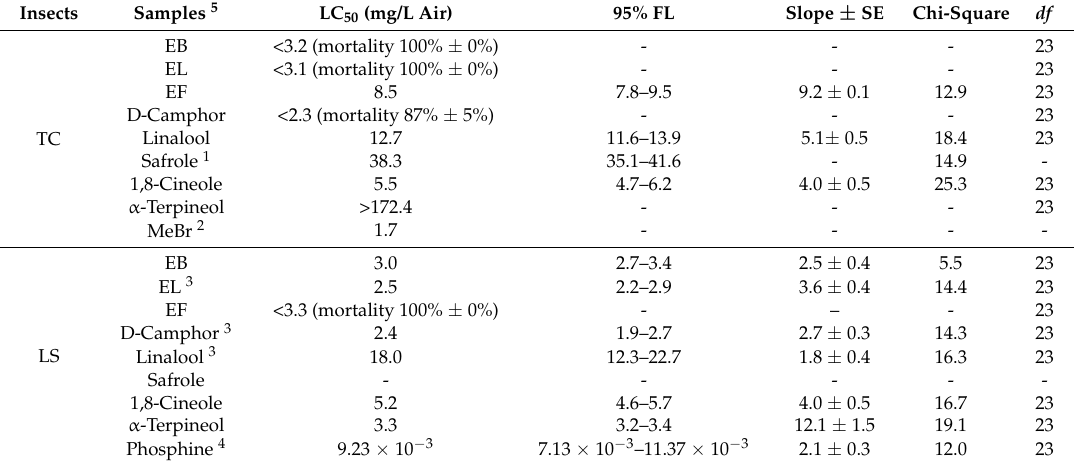
Table 2. Fumigant toxicity of essential oils and individual compounds against T . castaneum (TC) and L. serricorne (LS) adults at 24 h.